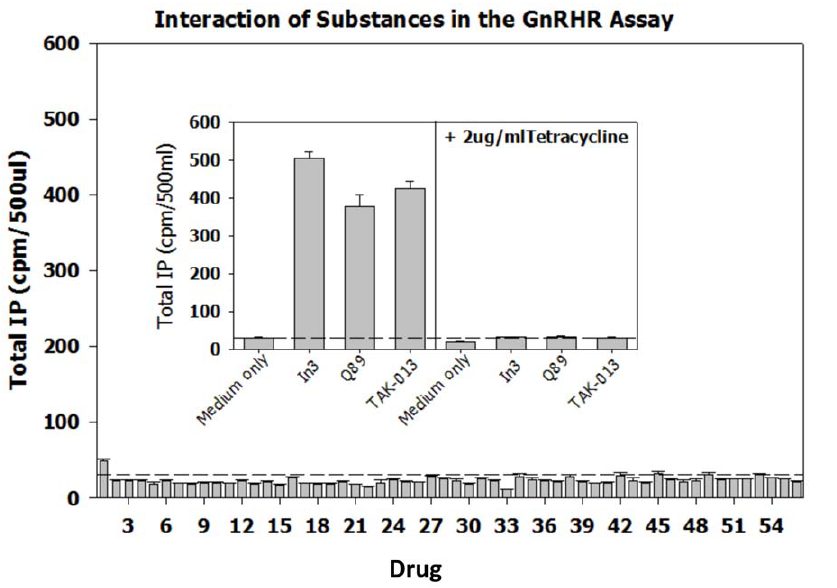
Figure 8. Performance of non-specific (expected negative controls) and positive controls for the GnRHR pharmacoperone assay. The non-specific compounds were selected from reagents that alter the level of cyclic nucleotides, block Ca2 + and Na channels, inhibit calmodulin, inhibit transcription, activate a range of receptors, cross link membrane proteins and otherwise perturb the cell. The dotted lines parallel to the X-axis show the response of the cells in the presence of medium only (i.e., no added drugs). The drugs, used at a concentration of 1 m g/ml were: 1. Urotensin II (neurosecretory peptide); 2. Octreotide Related Peptide; 3. Somatostatin; 4. Bombesin; 5. Calcitonin (salmon); 6. Growth Hormone Releasing Factor; 7. Thyrotropin Releasing Factor; 8. Galanin (human); 9. NPSF-Amide (SLAAPQRF-NH2); 10. Neuromedin U (rat); 11. BI 679 (the growth hormone releasing peptide, hexarelin); 12. Adiponectin (a hormone with broad impact on metabolism); 13. 1-(3-Dimethylaminopropyl)-3- Ethylcarbodiimide (a water-soluble protein crosslinker); 14. O2 9 -Monosuccinyl Guanosine 3 9 -5 9 -Cyclic Monophosphate Tyrosine Methyl Ester (cGMP analog); 15. 1-Ethyl-3-(3-Dimethylamino-Propyl)Carbodiimide-HCl (a water-soluble protein crosslinker); 16. D- b -3,4-dihydroxy-Phenylalanine (D- DOPA); 17. L-Noradrenaline; 18. Trifluoperazine (calmodulin antagonist); 19. Histone (from calf thymus) Type II-S (a basic protein); 20. N6-2 9 -O- Dibutyryladenosine 3 9 -5 9 -Cyclic Monophosphate (a cAMP analog); 21. Spermine; 22. Ouabain Octahydrate (Strophanthin-G) (sodium ion channel antagonist); 23. 3-Hydroxytyramine; 24. p-Nitrophenyl Phosphate; 25. 8-(4-Chlorophenylthio)-Adenosine 3 9 :5 9 -Cyclic Monophosphate; 26. Carbonyl Cyanide m-Chlorophenylhydrazone; 27. Guanosin-5 9 -triphosphate; 28. Adenylyl-imidodiphosphate (AMP-PNP); 29. p-Nitrophenyl- b -D-Galactopyrano- side; 30. Cytochrome-C; 31. Concanavalin A (a plant lectin that interacts with plasma membrane glycoproteins); 32. L-1-Tosylamide-2-Phenyl- Ethylchloromethyl Ketone (inhibitor of trypsin-like enzymes); 33. Actinomycin D (transcription inhibitor); 34. b -Nicotinamide Adenine Dinucleotide ( b - NAD); 35. Adenosine 5 9 -Monophosphoric Acid; 36. Nifedipine (Ca2 + ion channel antagonist); 37. D600 (Ca2 + ion channel antagonist); 38. 2-n-Propyl- Amino-indine; 39. Veratrine (Na channel inhibitor); 40. Vinblastine (microtubule inhibitor); 41. Cytochalasin D (blocks cellular actin polymerization); 42. Polyinosinic-Polycytidylic Acid (Poly[I]-Poly[C]) polymer; 43. Forskolin (activator or adenylate cyclase); 44. A23187 (Ca2 + ionophore); 45. SQ23,377 Ionomycin (Ca2 + ionophore); 46. U-73343 (inhibitor of inositol phosphate metabolism); 47. Creatine Kinase; 48. Deferoxamine Mesylate (metal chelator); 49. Flavin Mononucleotide; 50. [-]-Norepinephrine; 51. Adenosine-3,5 9 -Cyclic Monophosphothioate, Rp-Isomer; 52. N-nitro-L-arginine L- NAME Methyl Ester; 53. Acyline (GnRH peptide antagonist); 54. Asp2-GnRH (GnRH analog that binds GnRHR mutant E 90 K); 55. Buserelin (GnRHR peptide agonist); 56. Control (medium only); 57. In3 (non-specific for the V2R assay; non-peptide GnRH antagonist, structure [28]); 58. Q89 (non- specific for the V2R assay; non-peptide GnRH antagonist, structure [28]); 59. TAK-013 (non-specific for the V2R assay; non-peptide GnRH antagonist, structure [28]); 60. SR121463B (non-specific for the GnRHR assay, non-peptide V2R